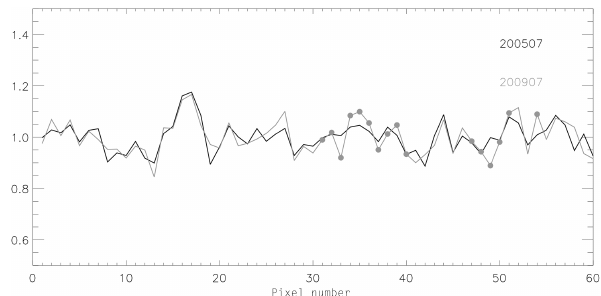
Figure 1. Smoothing array for stripes in version 1.0 OMI TCWV as a function of cross-track pixel number for July 2005 (black) and July 2009 (gray). The pixels affected by the row anomaly are indi- cated by